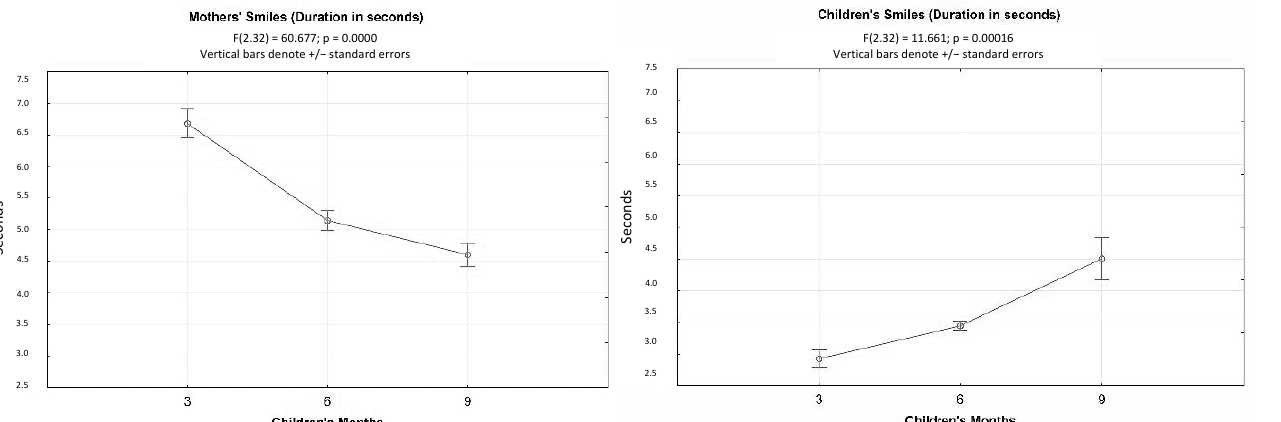
Figure 4. Mean and standard error of occurrences of maternal and infant smiles at three, six, and nine months.